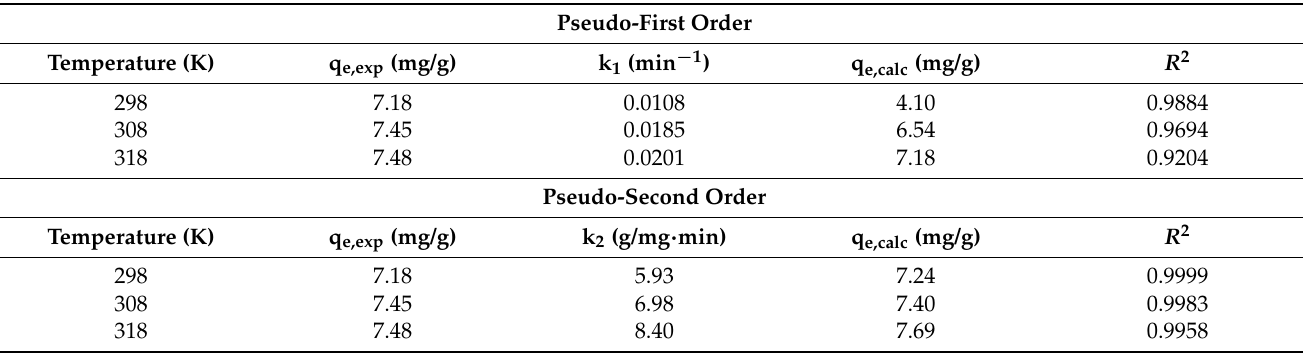
Figure 9. Pseudo-first order ( a ) and pseudo-second order isotherms ( b ). Table 3. Kinetic